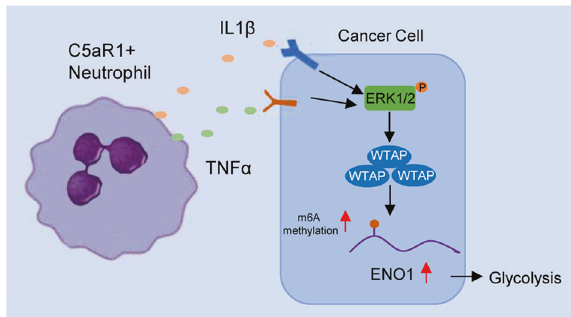
Fig. 7 Proposed model for C5aR1 + neutrophils in reprogramming breast cancer cell glycolysis. C5aR1-positive neutrophils-secreted IL1 β and TNF α cooperatively activate ERK1/2 signaling, which phosphorylates WTAP at serine341 and thereby stabilizes WTAP protein. The stabilization of WTAP further promotes RNA m6A methylation of ENO1, impacting the glycolytic activity of BC cells. Cell Death and Disease (2021)